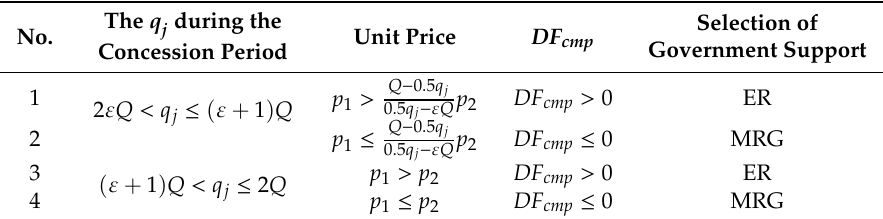
Table 2. Decision factor in di ff erent scenarios of unit